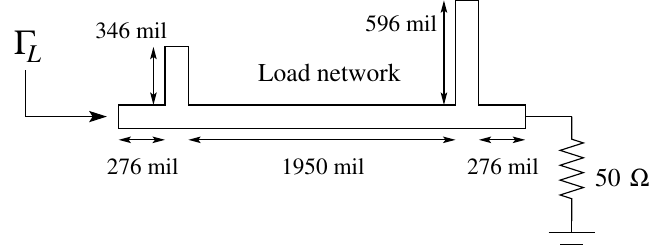
Figure 7. Schematic of the second passive load circuit (Load Circuit 2). The width of all the microstrip lines is 136.7